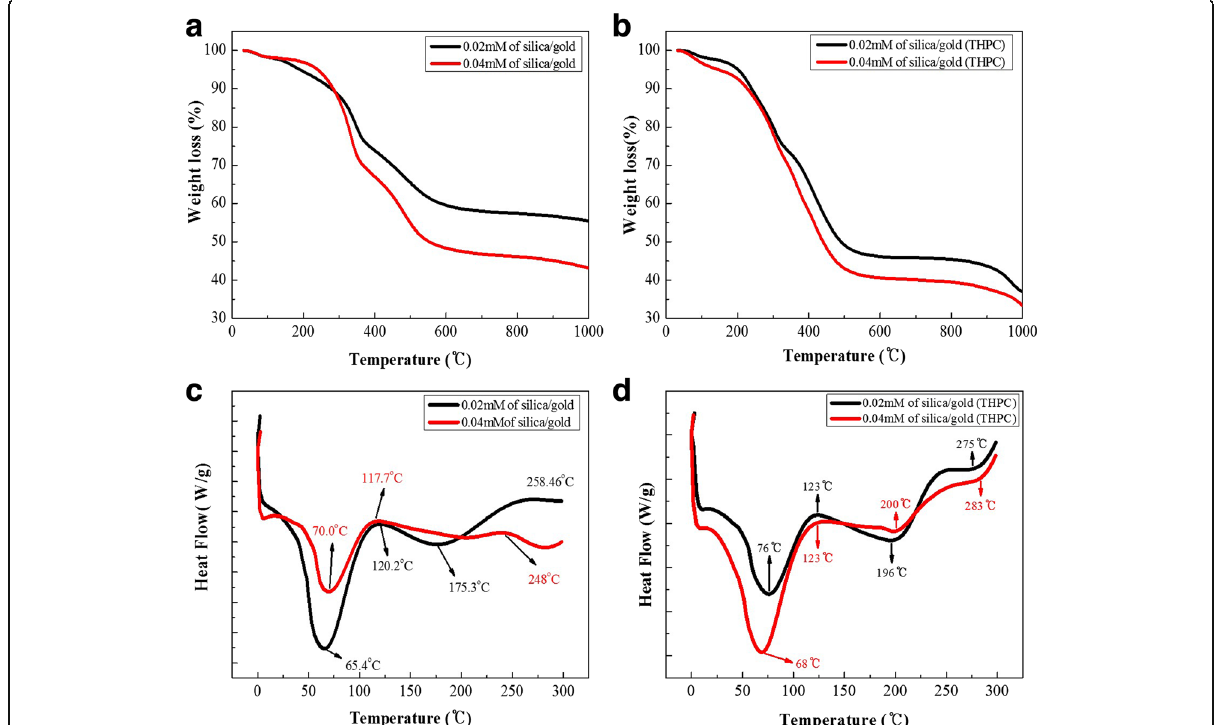
Fig. 10 (a-b) TGA (c-d) DSC results of cellulose-amino POSS hybrid